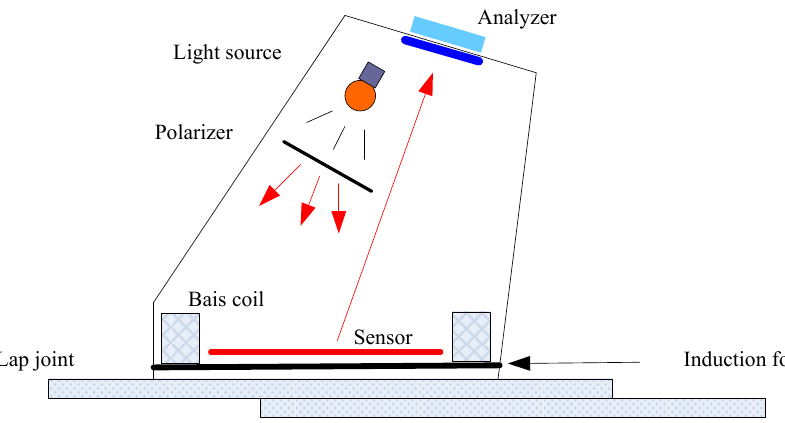
Figure 33. Basic schematic of magneto-optic imaging